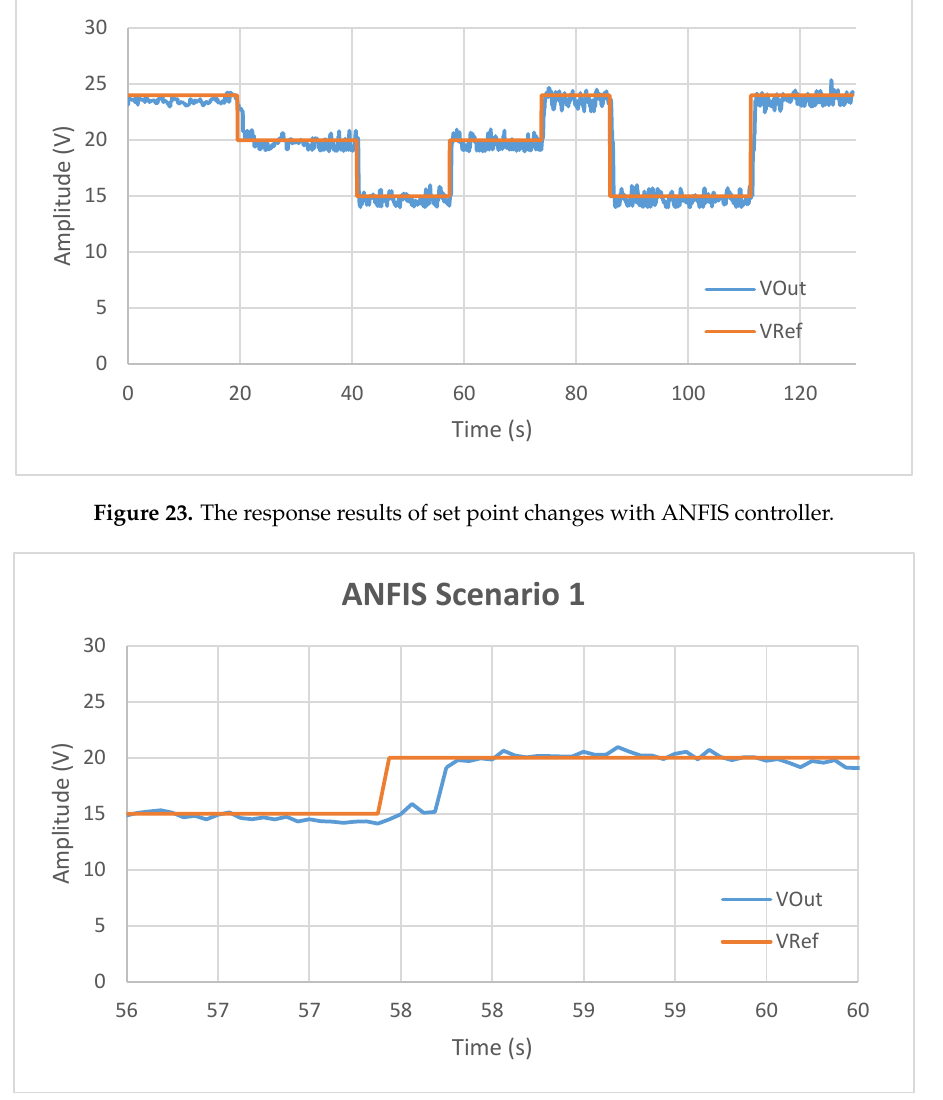
Figure 24. The response results of set point changes with ANFIS Controller on 56 s to 60 s.